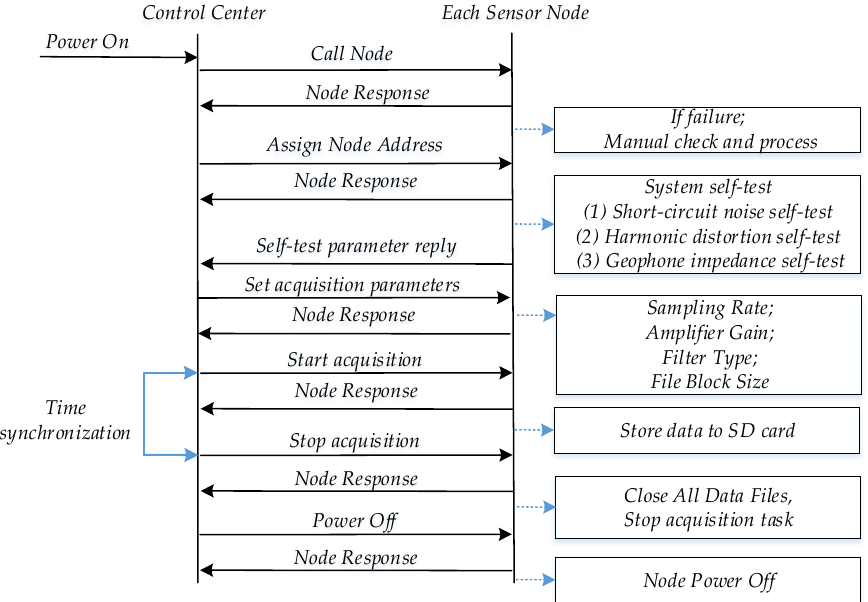
Figure 4. The simplified system working flowchart of GEIWR-III.